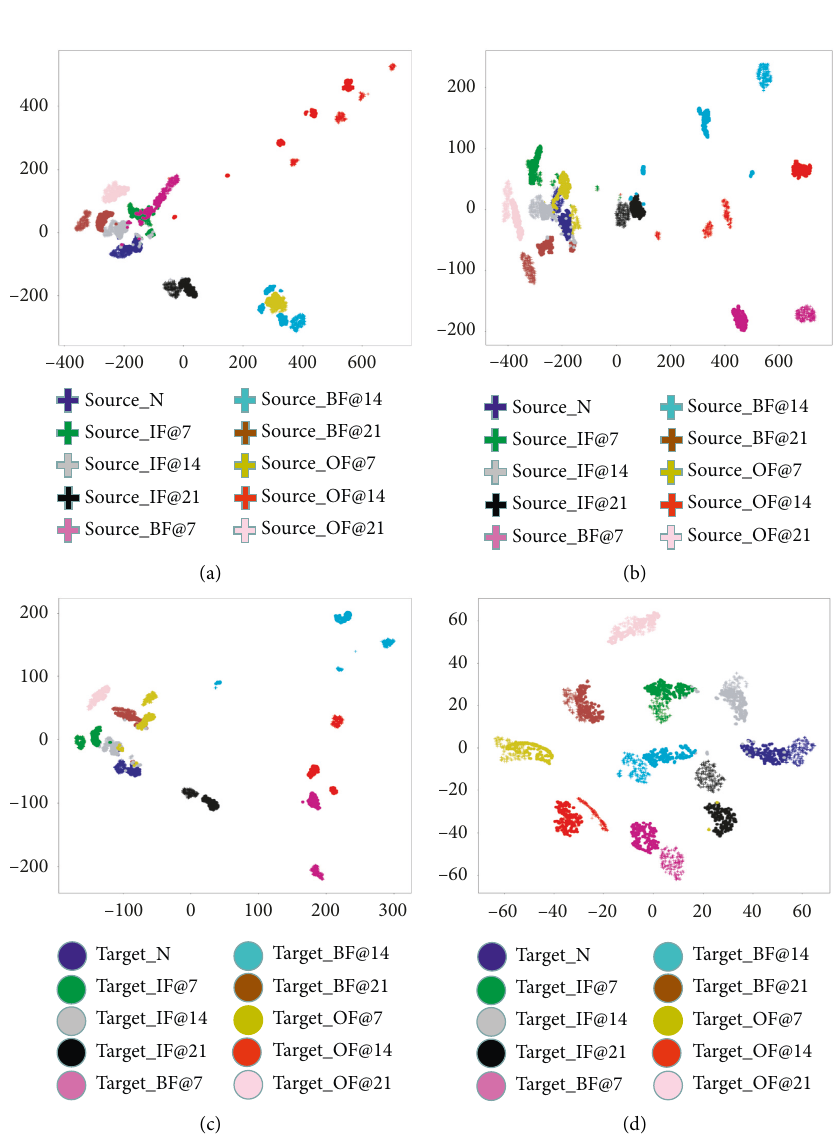
Figure 11: t-SNE visualization of features: (a) CNN; (b) DDC; (c) DAN; (d) the proposed.